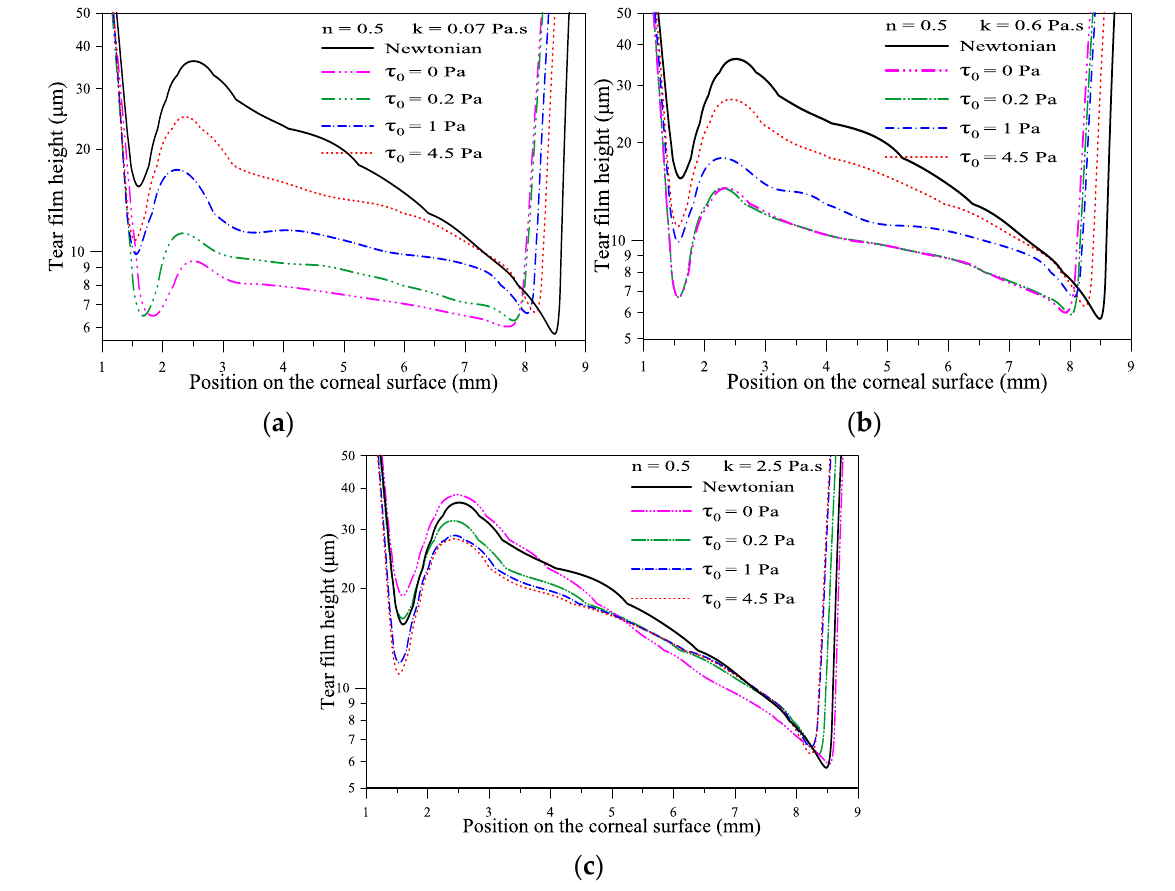
Figure 5. Variation of film thickness for different τ 0 , n = 0.5 at t = 0.18 s. ( a ) k = 0.07, ( b ) k =0.6, ( c ) k =2.5 Pa·s. Table 2. Minimum film thickness of viscoplastic tear at the end of blinking (t = 0.18 s).